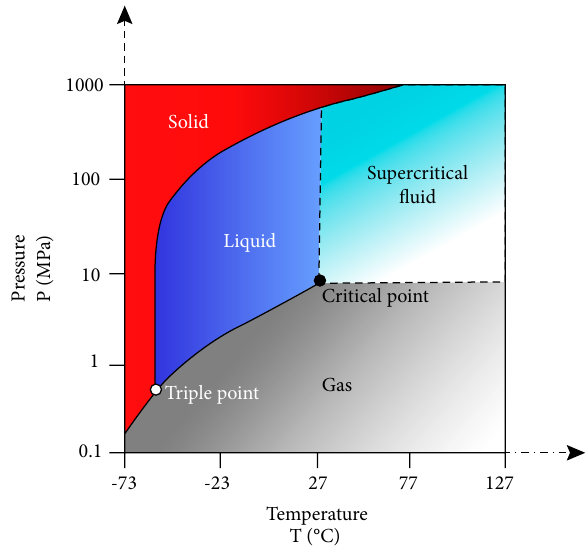
Figure 1: Phase change of carbon